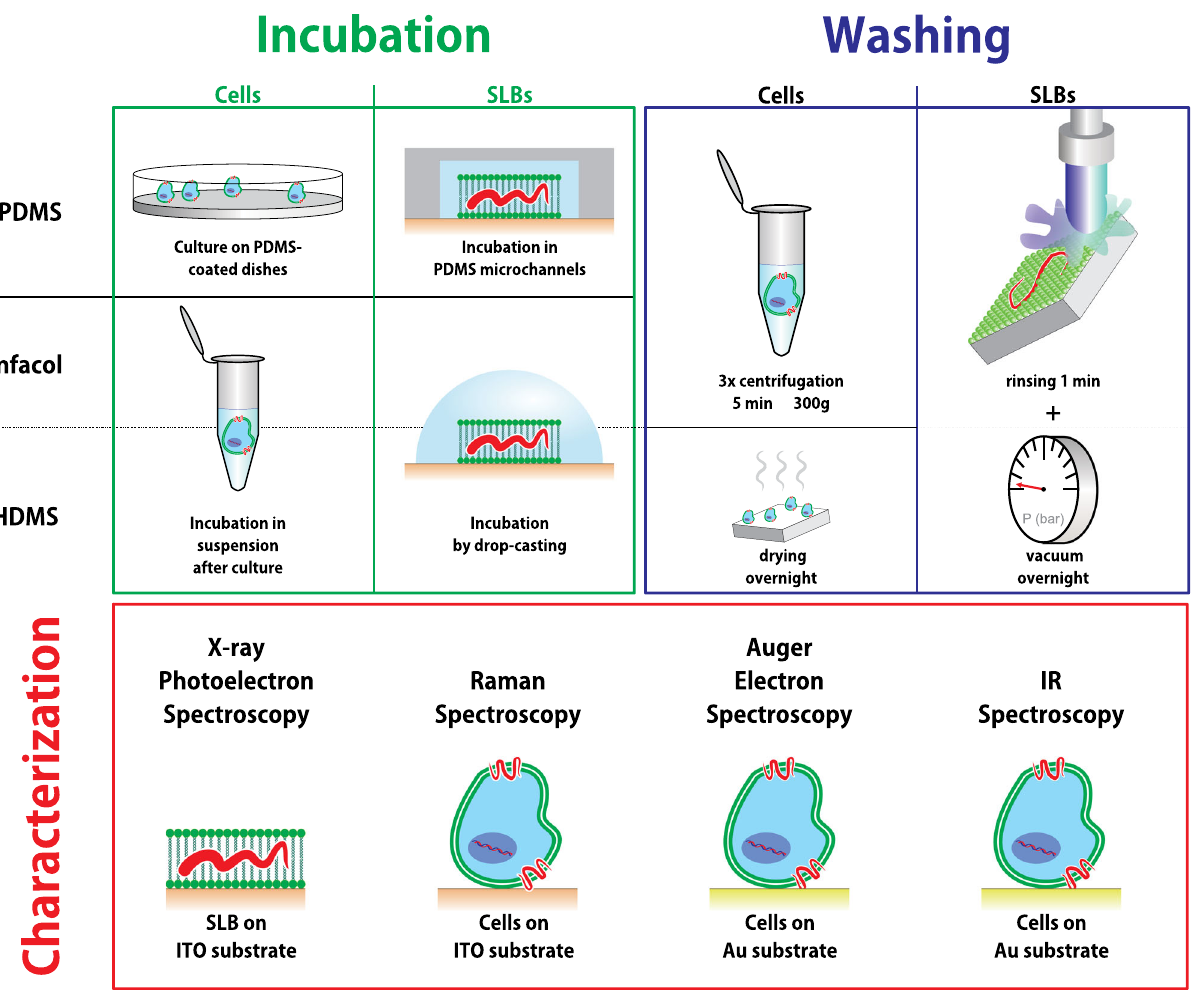
Fig. 4 Overview of the sample preparation and characterization steps. Cells and SLBs were fi rst incubated with PDMS, Infacol, or HMDS on substrates conforming to the requirements of the intended characterization technique. The organosilicon compounds are presented as “ red wavy lines ” and their hypothetical interaction with membranes (vide infra) is here suggested. The excess of organosilicon compounds was removed before samples were characterized with various